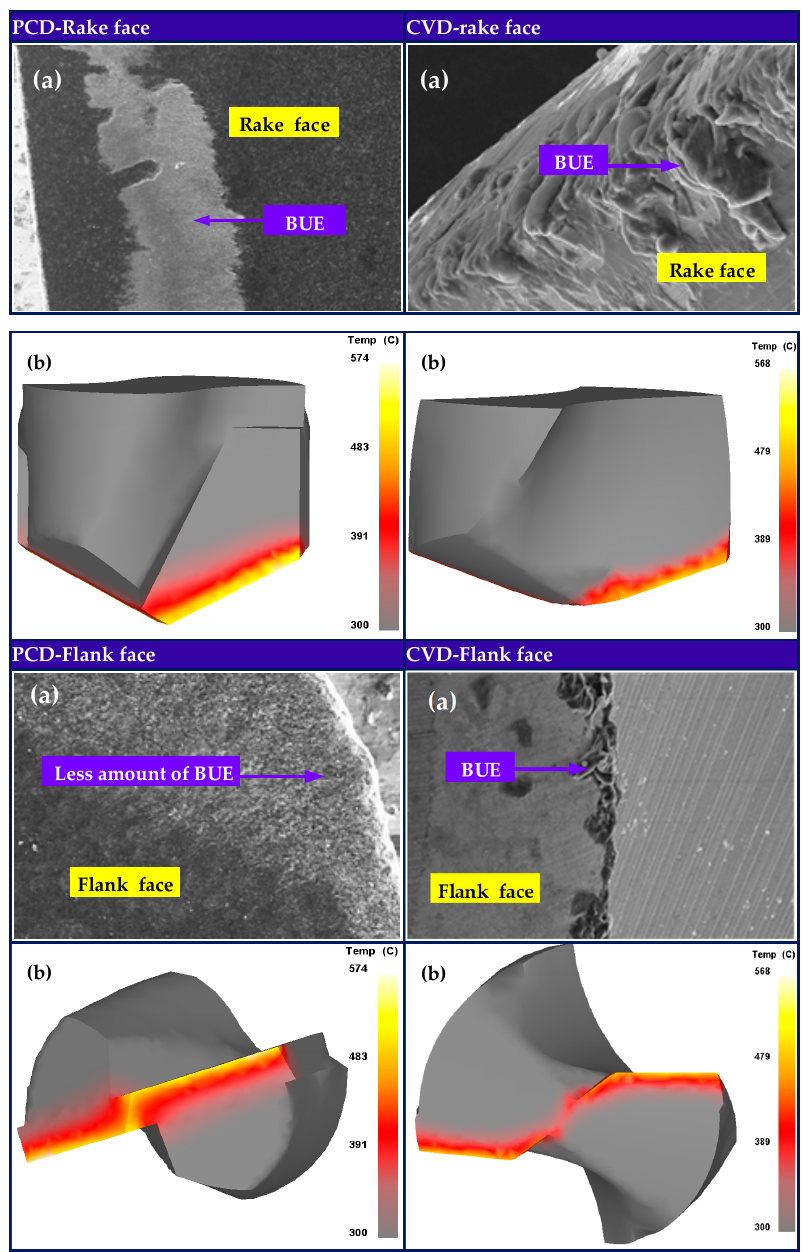
Figure 16. ( a ) Built-up edge and ( b ) temperature distribution on rake and flank faces of PCD and CVD diamond coated drills.